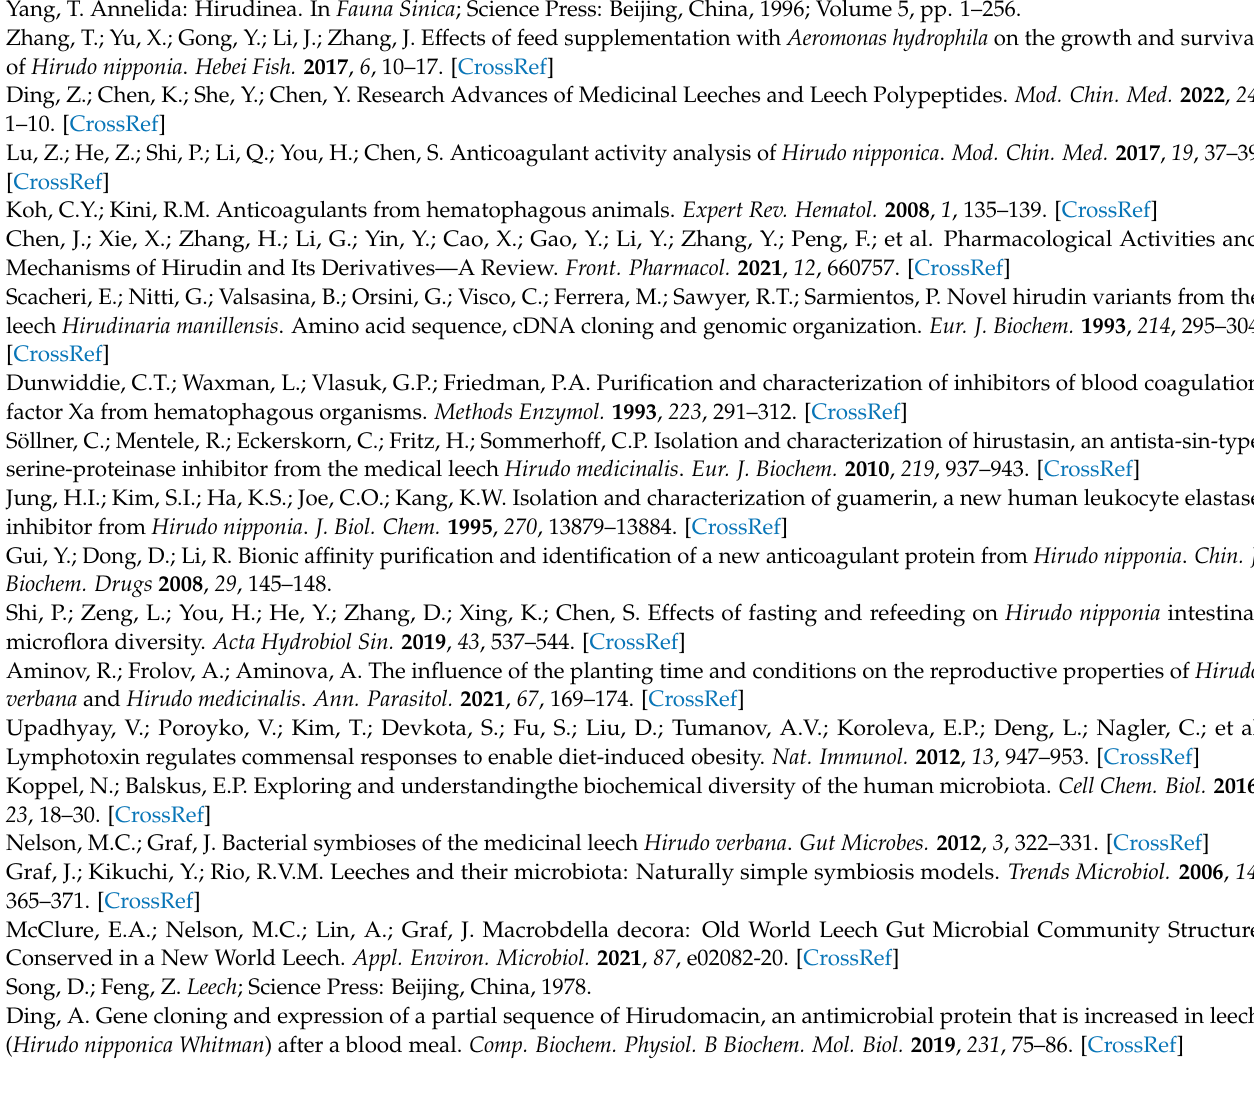
tion; Table S2: Statistic summary of sequencing data; Table S3: Statistic summary of De nove assembly data; Table S4: Statistics of functional annotation; Table S5: Gene expression in KEGG enrichment in FW and SW; Figure S1: Differential gene scatter diagram in FW leeches and SW leeches; Figure S2: Survival rate of FW leeches and SW